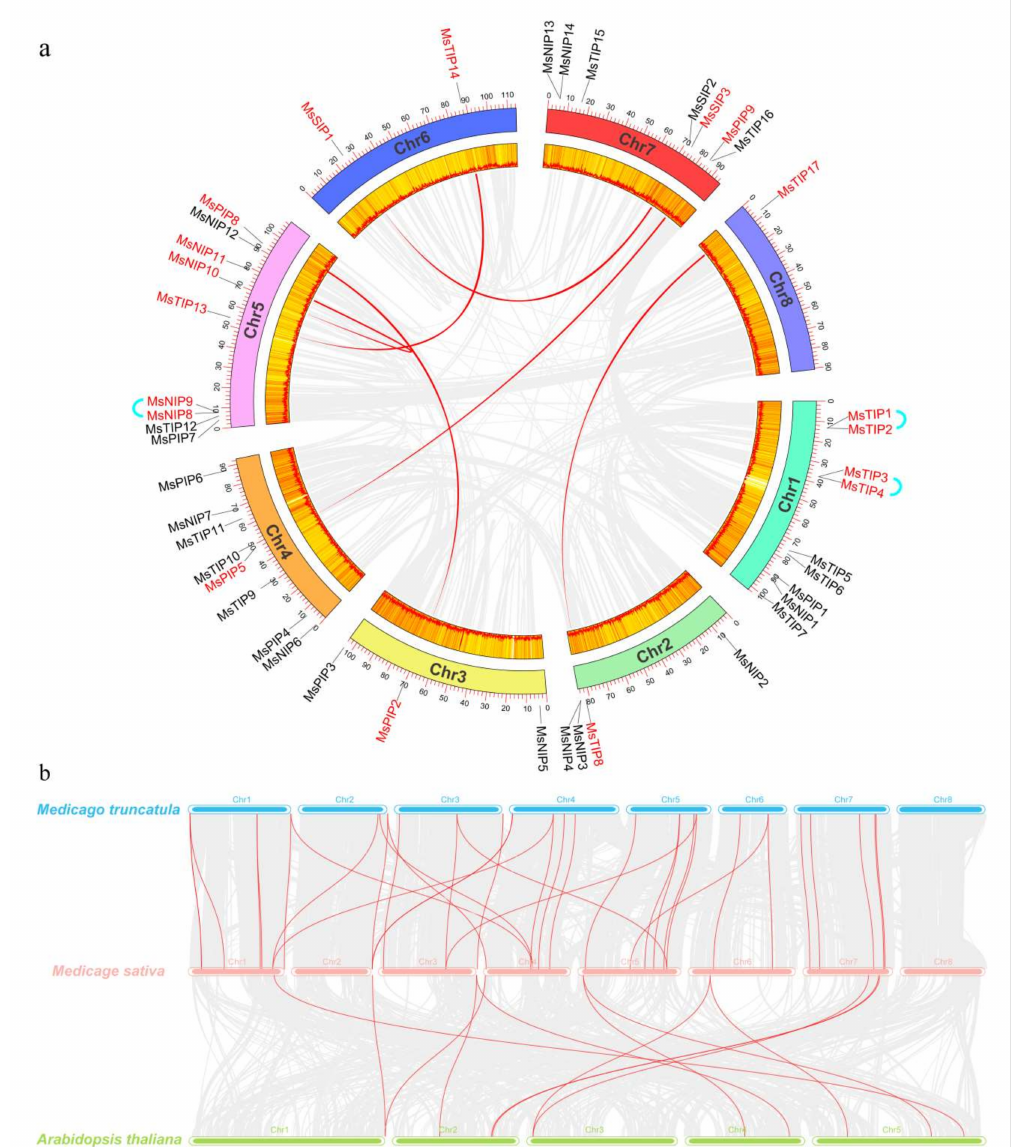
Figure 2. Chromosomal distribution of AQP family genes in M . sativa . ( a ) The chromosomal location and inter-chromosomal relationships of AQP genes on the eight chromosomes of M . sativa . The segmentally duplicated genes are in red and connected by red lines. The tandem duplicated genes are in red and connected by cyan lines; ( b ) Synteny analysis of AQP genes among M. sativa , Arabidopsis , and M. truncatula . Gray lines in the background indicate the collinear blocks within M. sativa , and M. truncatula / Arabidopsis , and the orange lines highlight the syntenic AQP gene